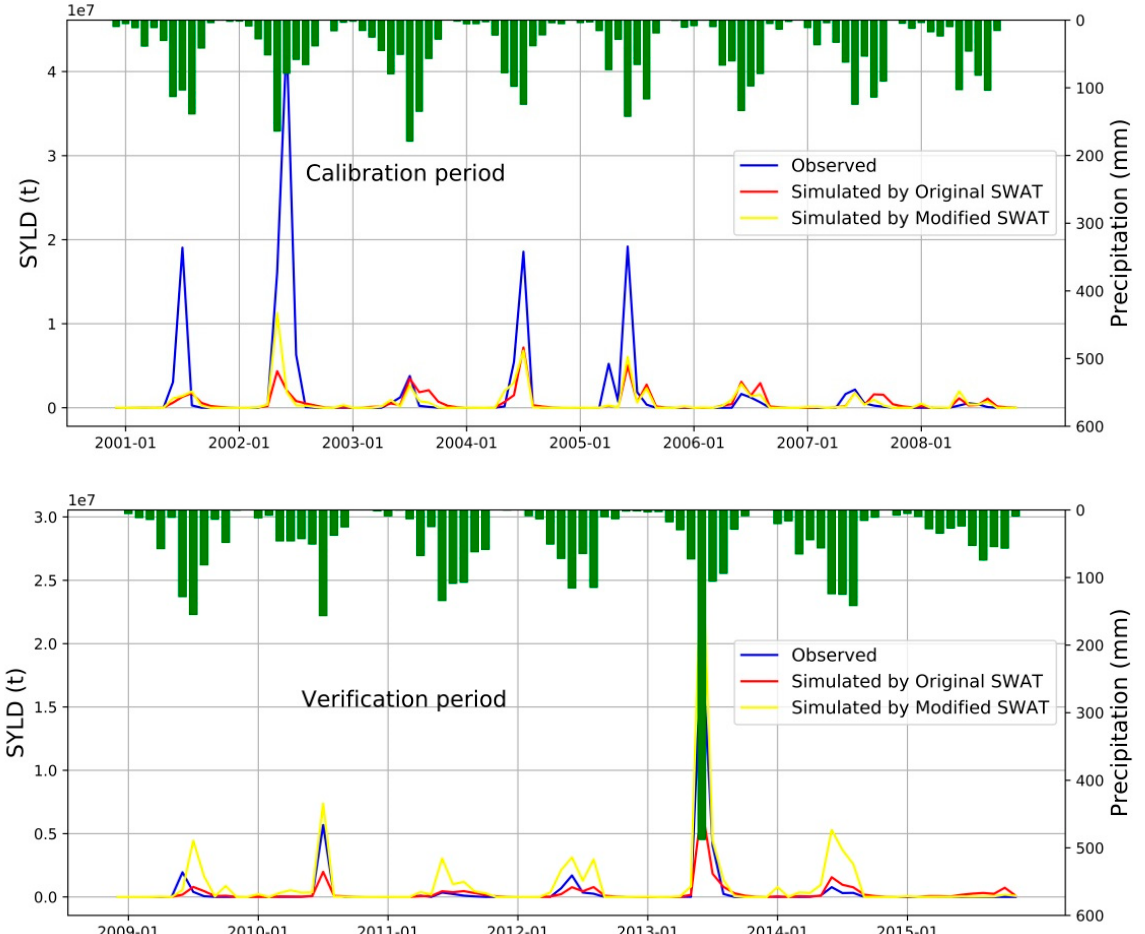
Figure 7. Temporal variability of observed and estimated monthly sediment yield from the original SWAT and modified SWAT with MODIS- NDVI . The bar plot represents the corresponding monthly rainfall.